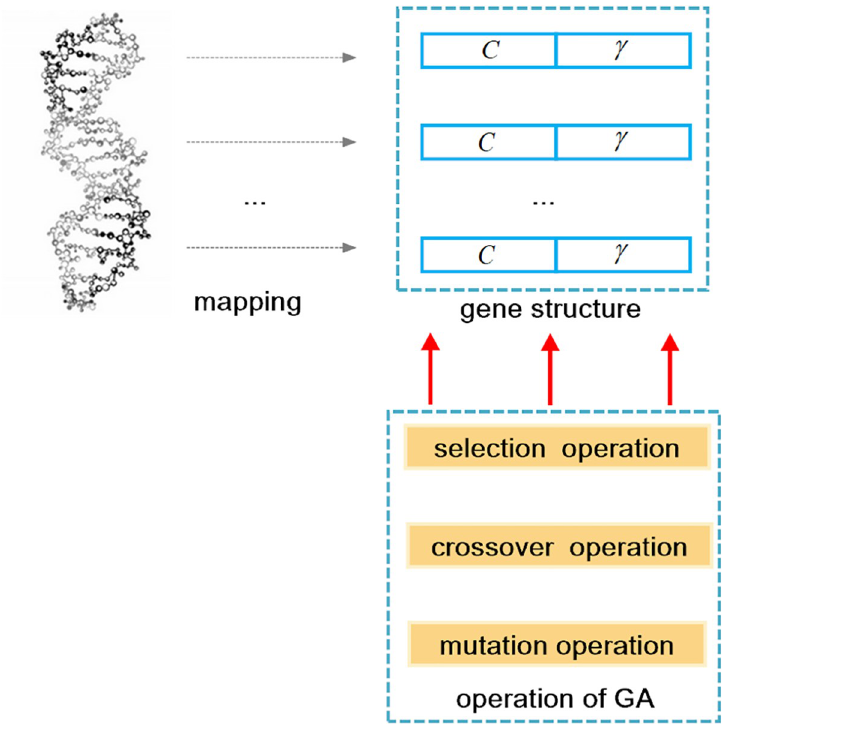
Fig 7. The relationship between the GA and the